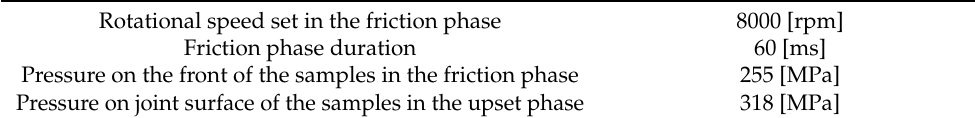
Table 2. Parameters of high-speed friction welding of 316L steel after HE.